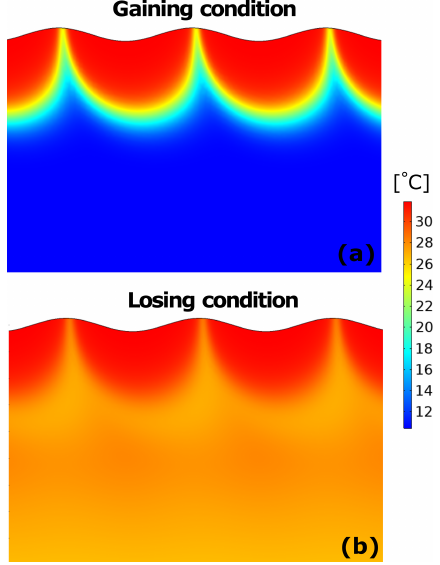
Figure 6. Snapshots of temperature distributions in the sediment on 22 July 2017 at 17:00 for (a) gaining and (b) losing groundwater